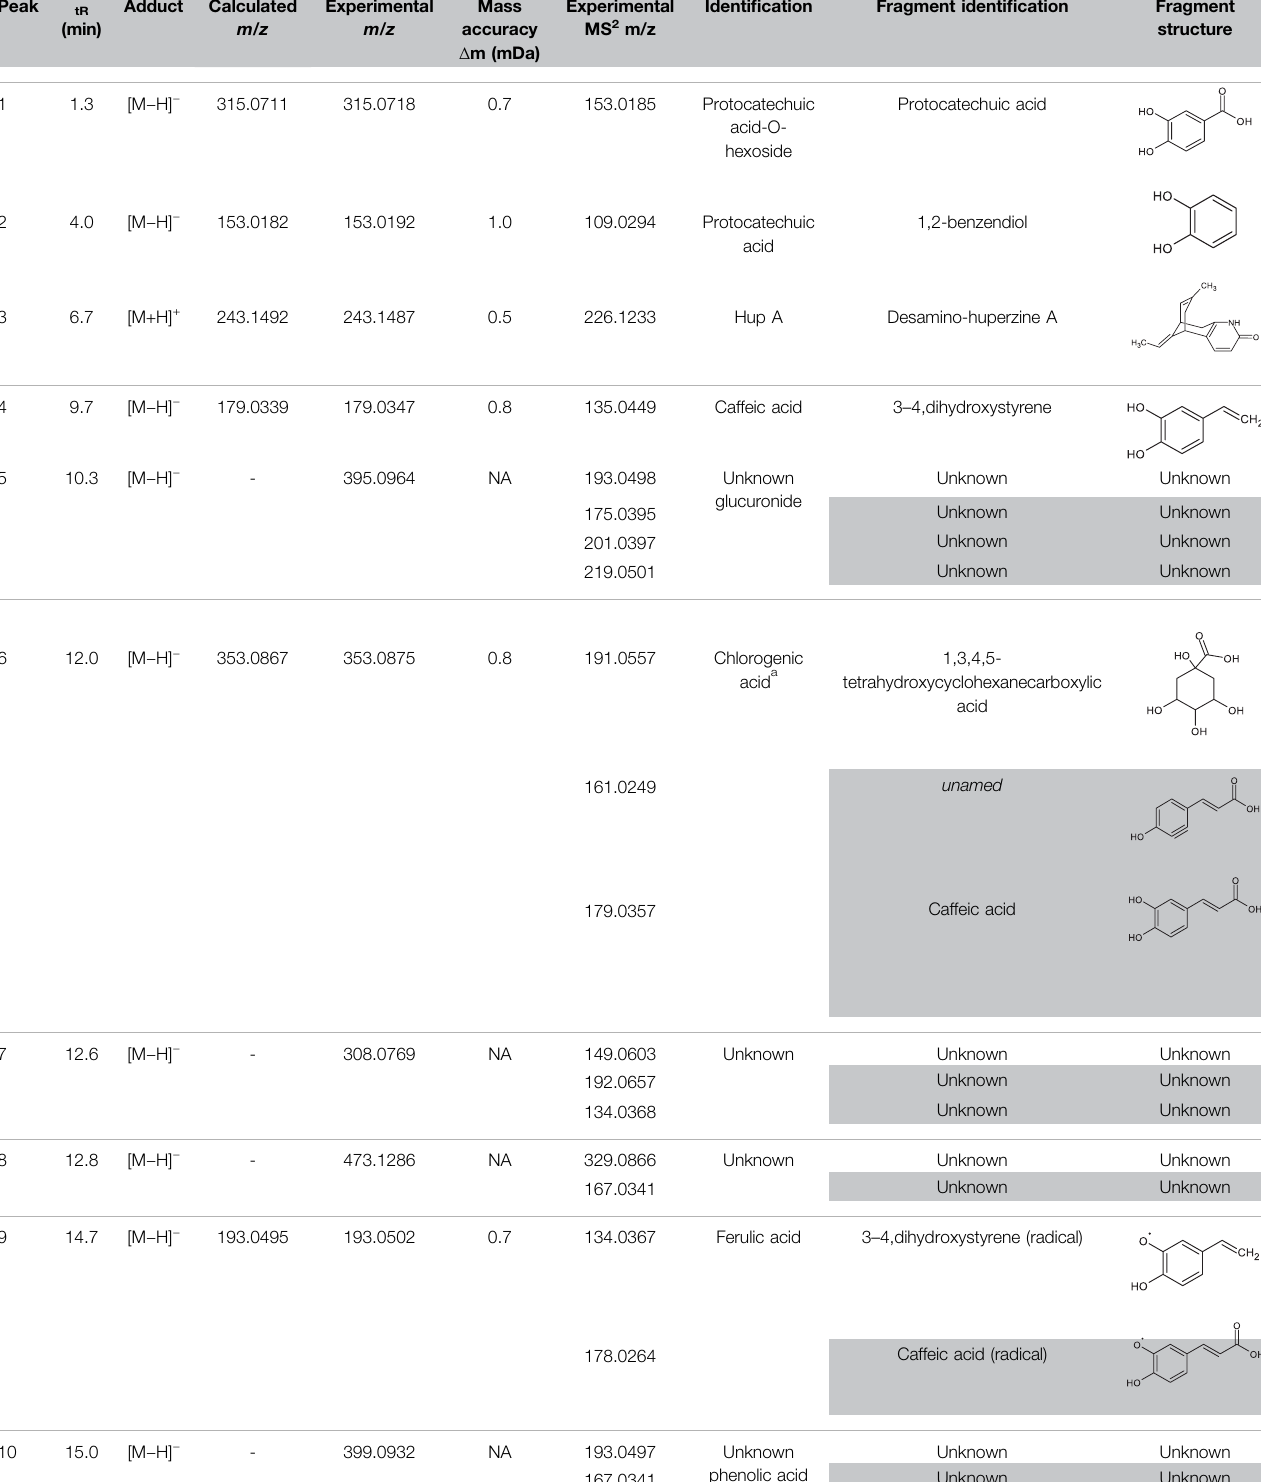
TABLE 1 | Phytochemical composition of NSP01-TE and NSP01 using UHPLC-DAD-ESI-MS/MS analysis. Peak tR (min)